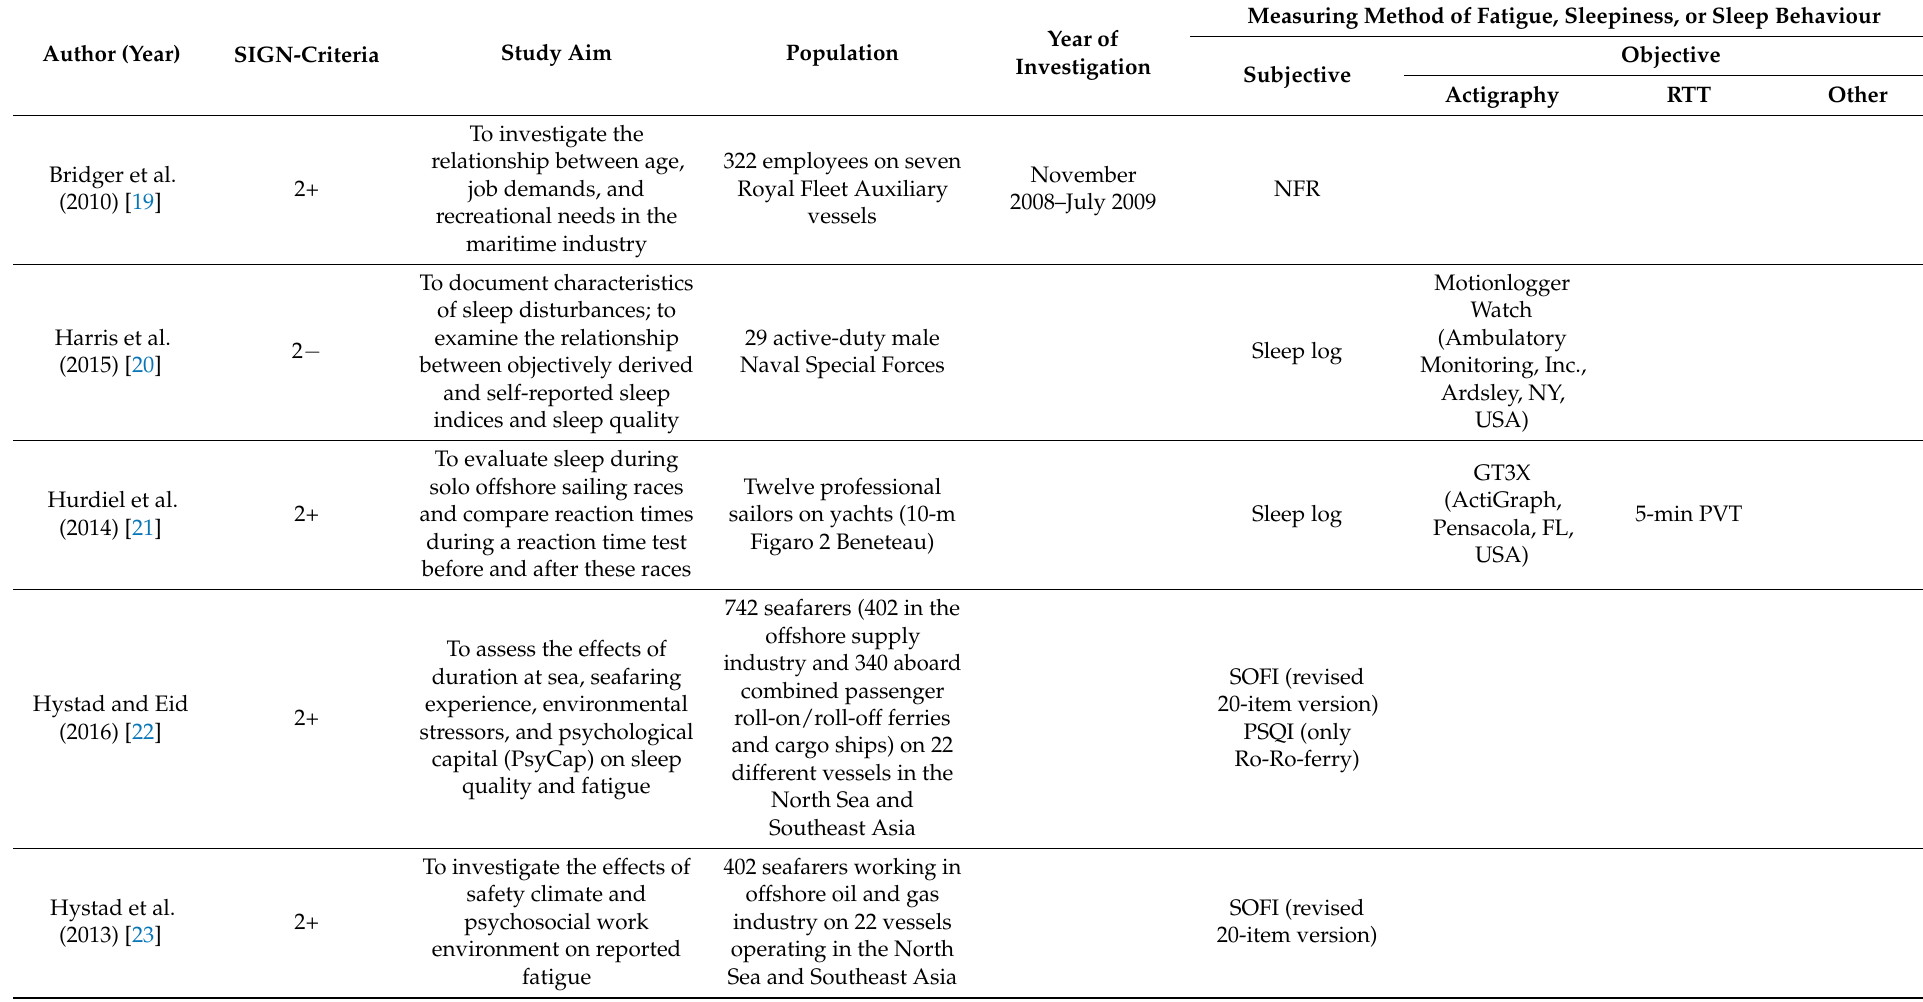
Table 1. Characteristics and methods of the selected